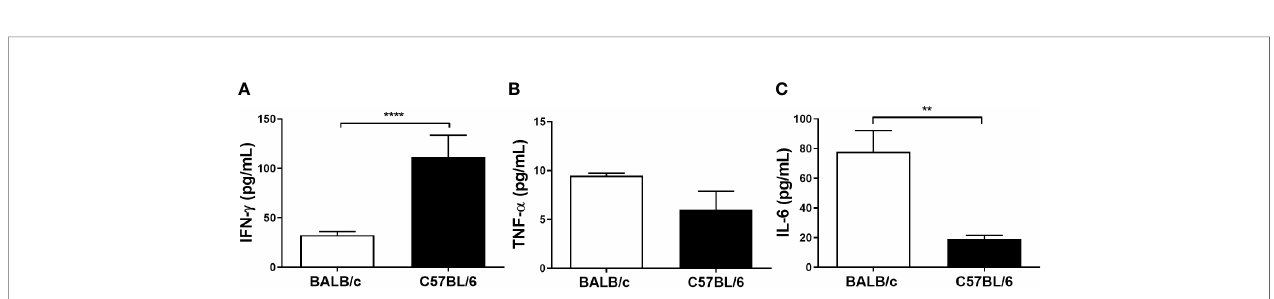
FIGURE 2 | Cytokine levels of BALB/c and C57BL/6 mice infected with L. amazonensis . Homogenates of L. amazonensis -infected BALB/c and C57BL/6 paws for 11 weeks were submitted to the CBA assay. (A) Measurement of IFN- g , (B) TNF- a , and (C) IL-6 levels after 11 weeks of infection. Data represent the mean ± SEM of fi ve mice groups. ** Signi fi cant difference in relation to the opposite strain infected by L. amazonensis , p ≤ 0.01; ****p ≤